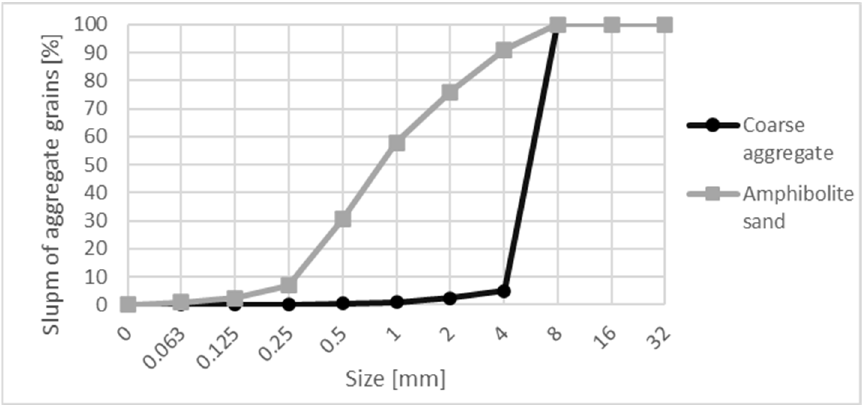
Figure 1. Sieve analysis of natural aggregate fraction 0/4 (amphibolite sand) and coarse aggregate fraction 4/8